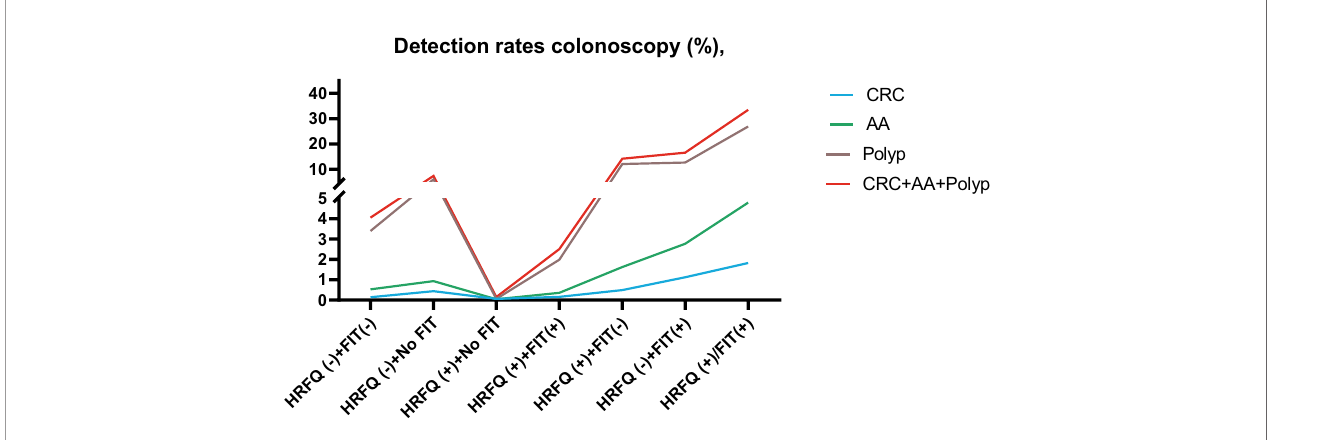
FIGURE 7-3 | Comparison of colonoscopy results among different screening methods in Tianjin CRC screening program.